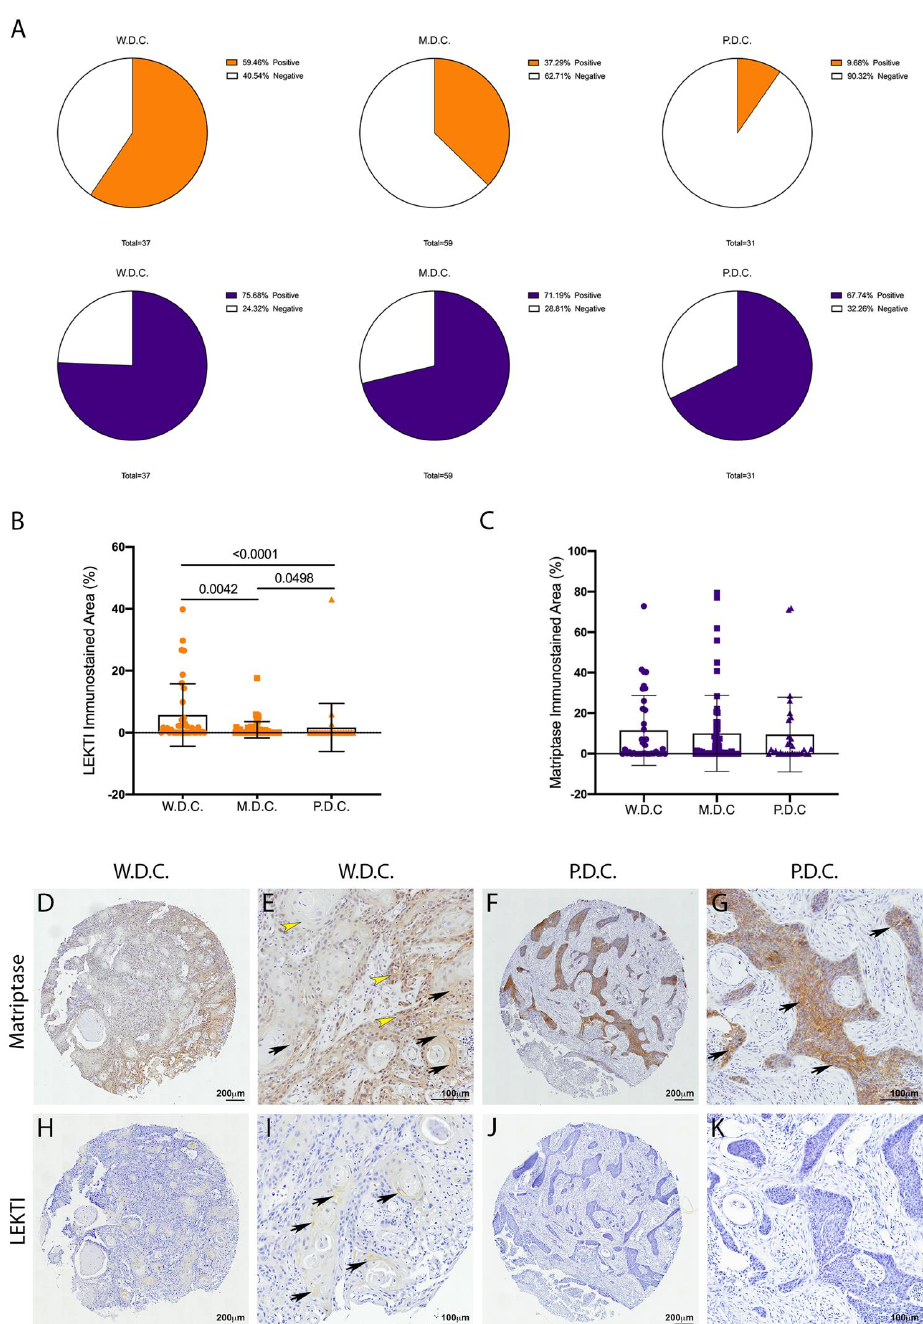
Figure 1. Unlike LEKTI, matriptase is not modulated in poorly differentiated carcinomas. ( A ) IHC staining for